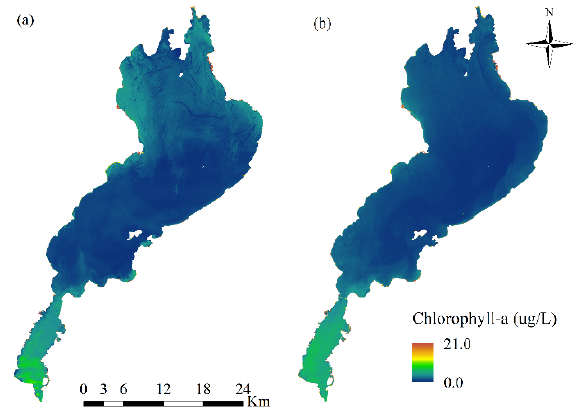
Figure 2. Estimated chlorophyll-a for Lake Biwa using two different satellite sensors: (a) Landsat-8 image and (b) Sentinel- 2A image for August 2018. (Note: ug/L represents microgram per liter).